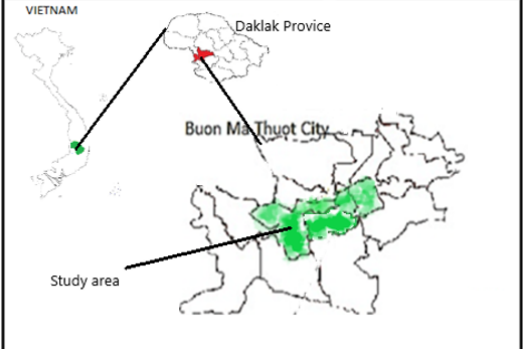
Figure 1. The study area (Source: Dak Lak Provincial People’s Committee Portal